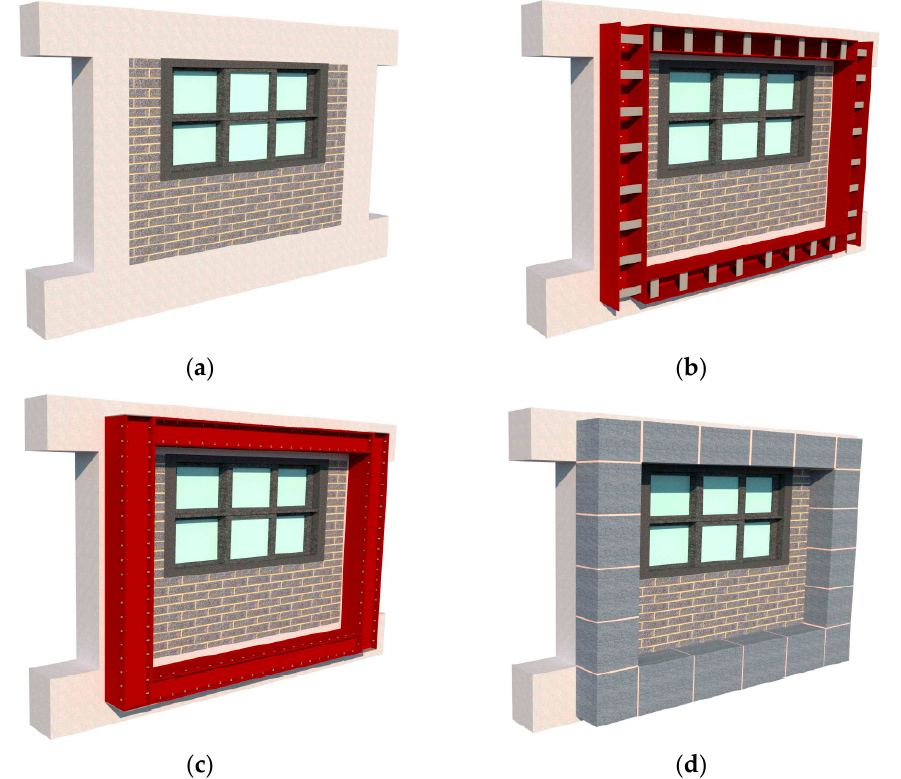
Figure 2. Retrofitting procedure using the NoWS system. ( a ) Cleaning the surface of the existing RC frame; ( b ) attaching the C-shaped steel channel to the surface; ( c ) bolting between the steel channel and cover; ( d ) and finishing off the retrofitted surface.